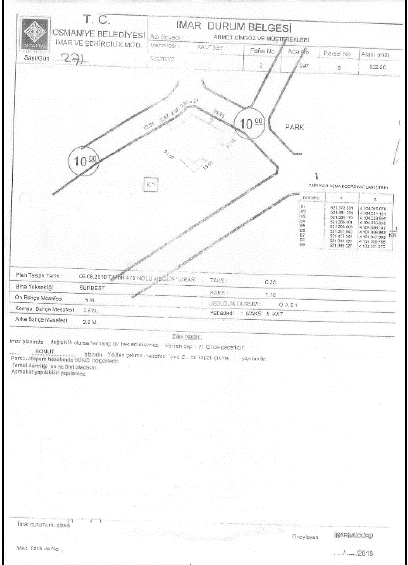
Figure 2. Zoning status document (sample form Osmaniye, Turkey)